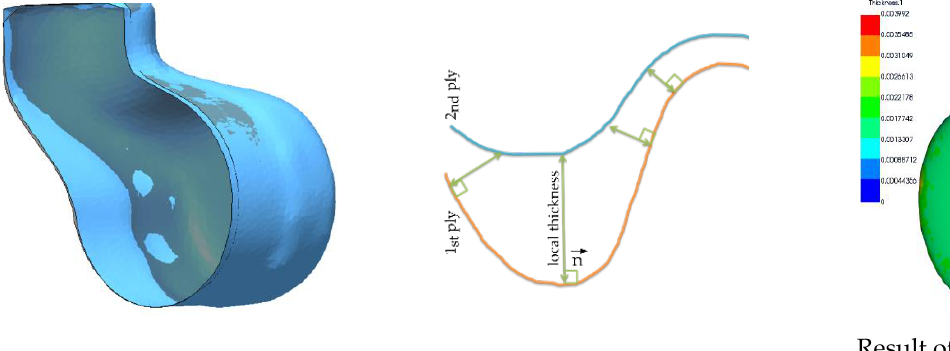
Figure 11. Determination of local ply thickness from laser line scanning result.